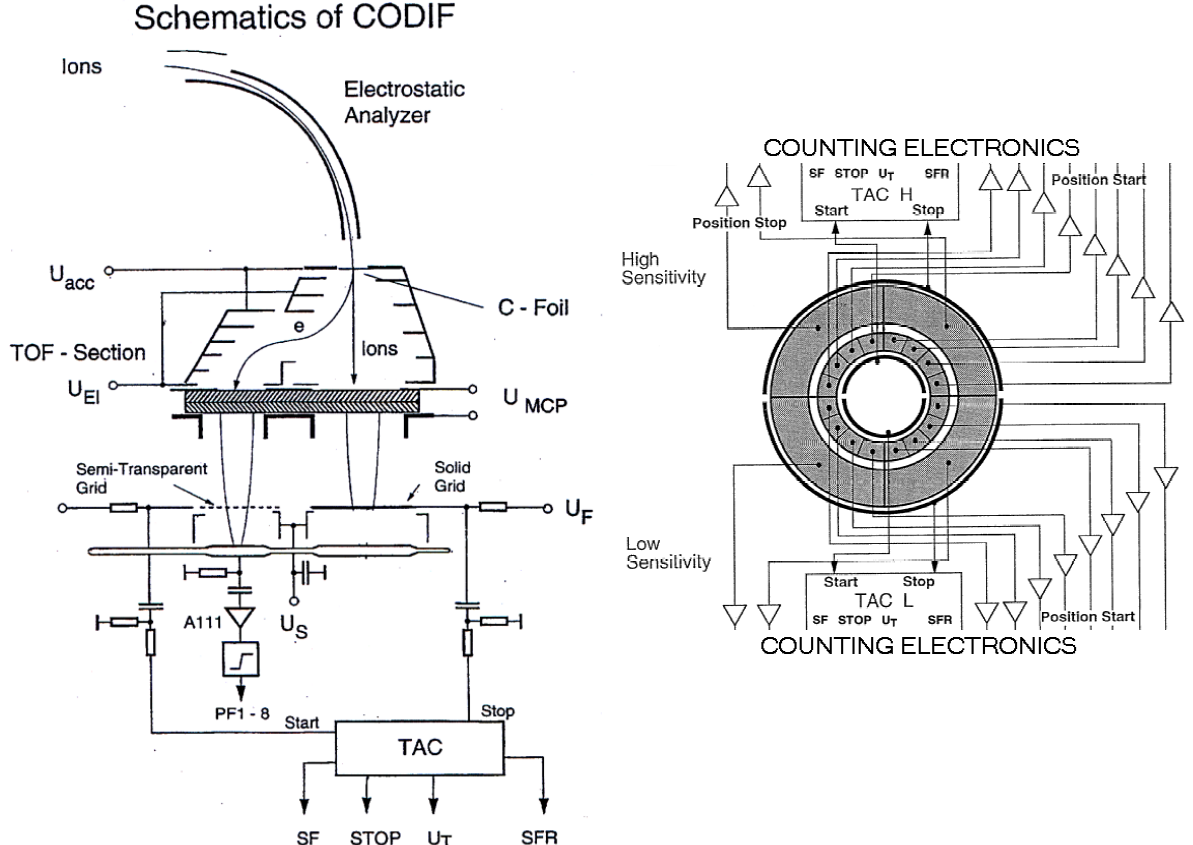
Fig. 11. The CODIF sensor: schematics (left) and MCP sectoring